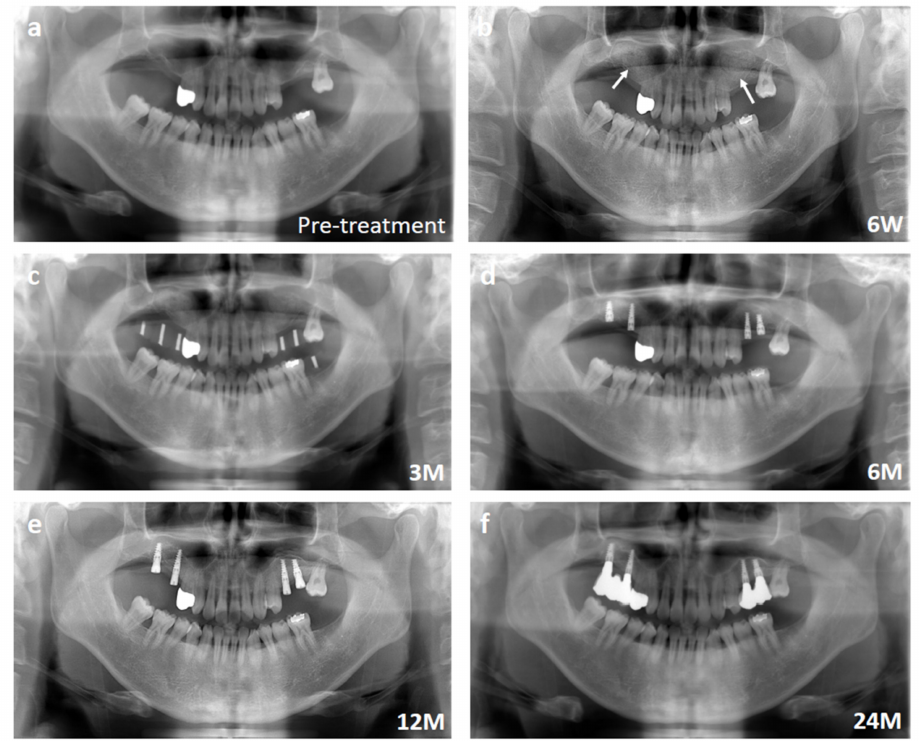
Figure 4. Representative panoramic radiographs of the sinus floor augmentation case. ( a ) Pre- treatment. Note that the height of alveolar bone was extremely thin. ( b ) Six weeks after transplan- tation. White arrows indicate the elevated sinuses. ( c ) Three months after transplantation. ( d ) Six months after transplantation. ( e ) Twelve months after transplantation. ( f ) Twenty-four months after transplantation.